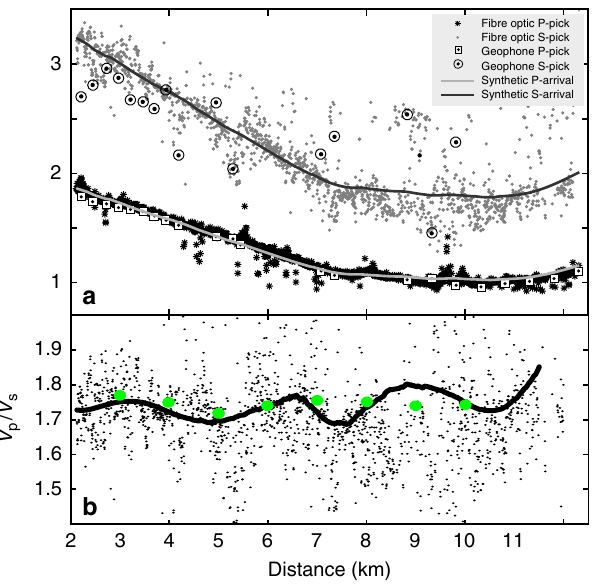
1.61.9 1.71.8 V s / V p Fig. 6 Exploration studies using conventional seismological methods and a fi bre-optic telecommunication line. a P- and S-waves ’ travel times automatically picked along the pro fi le: each symbol represents a P- (black star) and S- (grey dots) arrival times on the DAS records. The white squares with black dot and the white circle with black dot correspond to P- and S-wave travel times, respectively, picked on the geophone records with the same automatic picker. The continuous grey (black) lines correspond to theoretical arrival times for the inverted hypocentre using P- and S-wave picks from the cable (respectively). b Observed V p / V s ratio computed at all traces and compared with the results obtained from the travel time tomography (green dots) obtained from more than 2000 local earthquakes over 1.5 years 41 . The black line corresponds to the polynomial (Savitsky – Golay) smoothing fi lter of order 5 with size frame ~3 km long through the fi bre-optic V p / V s individual